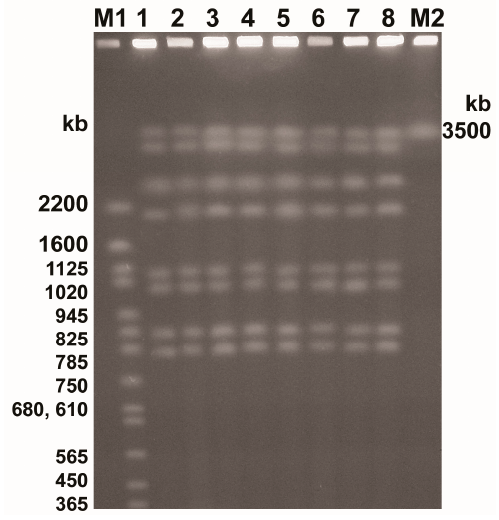
Figure 1. Electrophoretic karyotypes of different Candida albicans ATCC 10231 morphotypes, after treatment with peppermint oil (PO) and clove oil (CLO). M1 —DNA size marker Saccharomyces cerevisiae YNN295 (Bio-Rad); 1 —control; 2 —PO/0.25; 3 —PO/0.015; 4 —PO/0.0075/1; 5 —PO/0.0075/2; 6 —CLO/0.25; 7 —CLO/0.125; 8 —CLO/0.0075; M2 –DNA size marker Schizosaccharomyces pombe 972h-(Bio-Rad). Acronyms are composed as follows: essential oil type/oil concentration/isolate